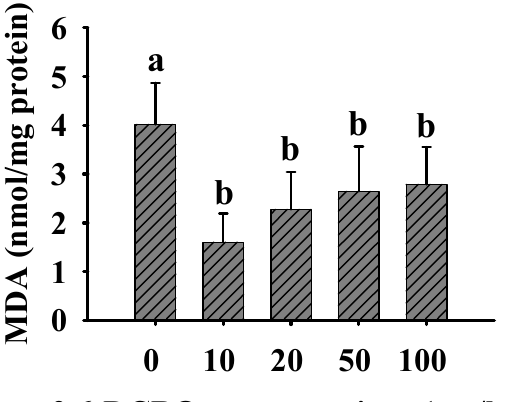
Figure 4. The effects of different concentrations of 2,6-DCBQ on the MDA contents of mice, after 30 d of exposure. Values are plotted as the mean ± SD, and the lowercase letters above the bars represent a significant difference between groups.